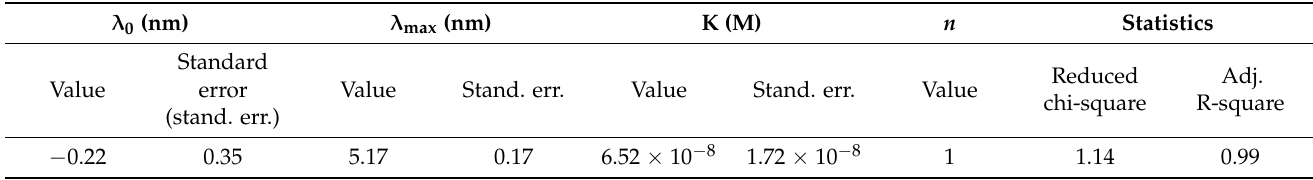
Table 1. Hill parameters relative to Equation (1) for BSA